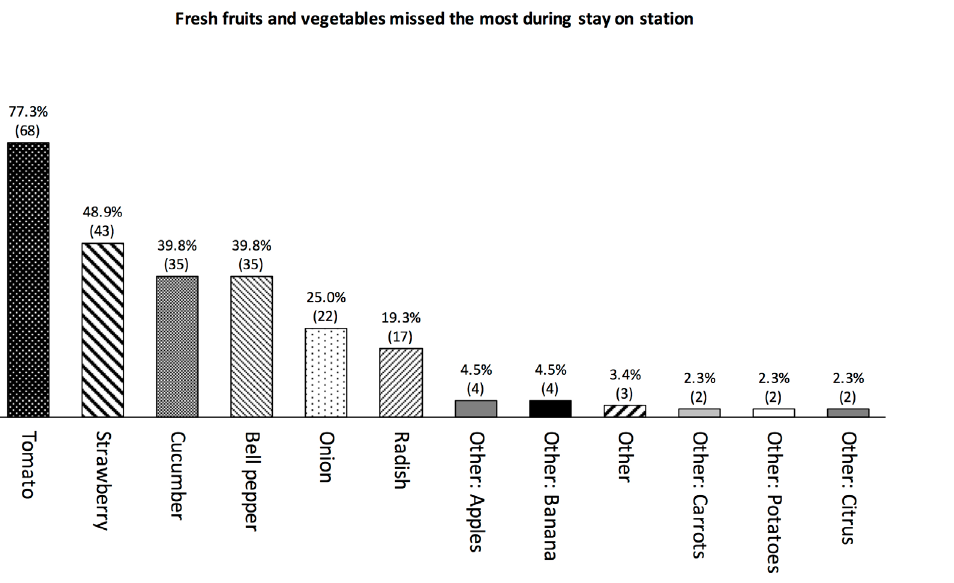
Figure 4: The 85% of respondents indicating that the availability of fresh fruit, vegetables and herbs grown on the Neumayer Station (85%, 88 individuals) would improve their overall well-being were asked to choose up to three crops from the crops listed in the category ‘Fruits and vegetables’ or to make their own suggestions. The presented data consists of a total of 237 answers.